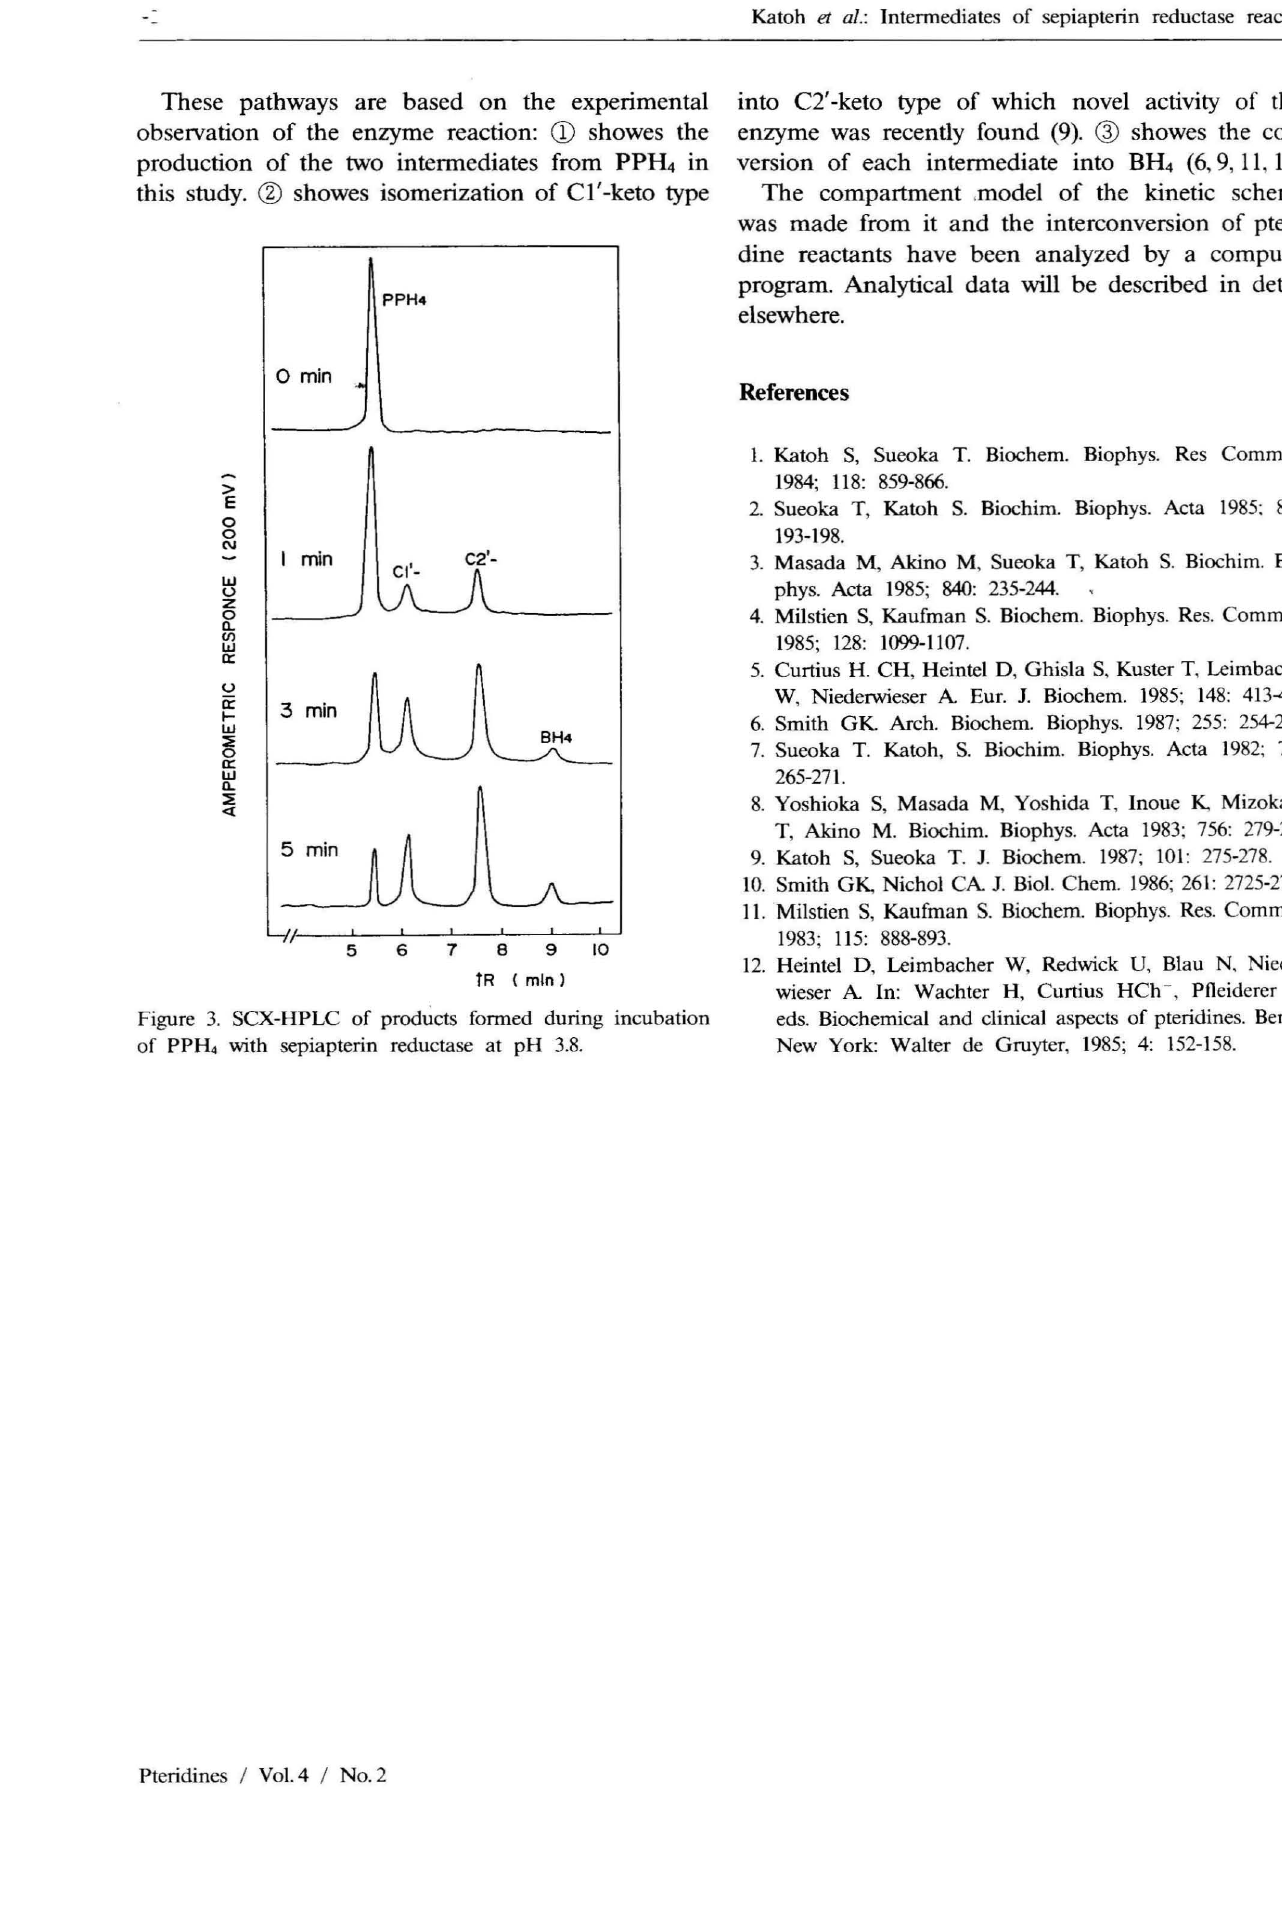
Figure 3. SCX-HPLC of products fonned during incubation of PPH 4 with sepiapterin reductase at pH